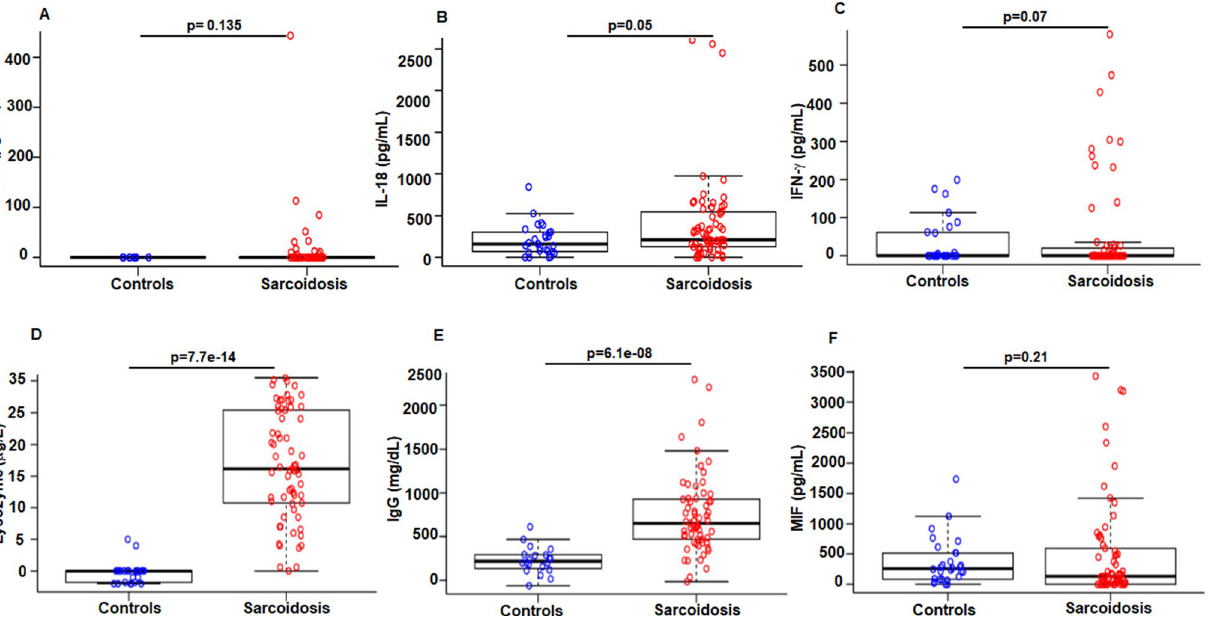
Figure 1. Comparison of levels of serum cytokines and biomarkers in sarcoidosis patients and healthy controls. The levels of cytokines and biomarkers were measured in serum samples via ELISA. The box plots were generated using programming language R and Mann–Whitney U test was applied. The central horizontal bar in the box plot represents the median value. There was no significant difference in levels of IL-6 between sarcoidosis patients and healthy controls ( p = 0.135) ( A ). Sarcoidosis patients displayed significant higher levels of serum IL-18 ( p = 0.05), ( B ). There was no significant difference in levels of IFN-γ ( p = 0.07) ( C ). Sarcoidosis patients displayed significant higher levels of serum lysozyme ( p = 7.7e−14) ( D ), and IgG ( p = 6.1e−8) ( E ) as compared to healthy controls. ( F ) There was no significant difference in levels of MIF ( p = 0.21), between sarcoidosis patients and healthy controls. p value < 0.05 was considered to be